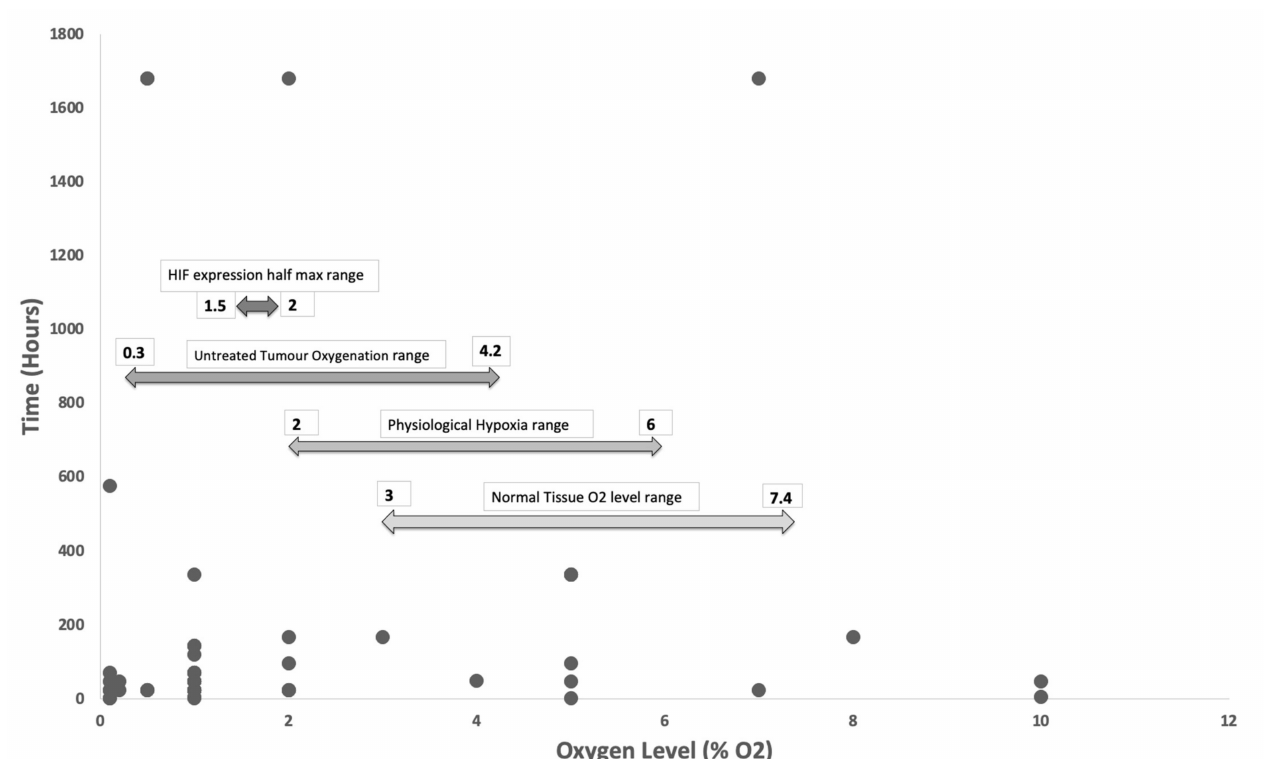
Figure 2. Hypoxia level vs Duration. 71% of studies explored oxygen levels of 1% or below and 71% of studies exposed in vitro cultures for 72 h or less. Arrows demonstrating oxygen range of normal tissue, physiological hypoxia, untreated tumours pathological hypoxia and HIF half maximum expression range. Several studies used oxygen levels outside of the range of physiological tissue